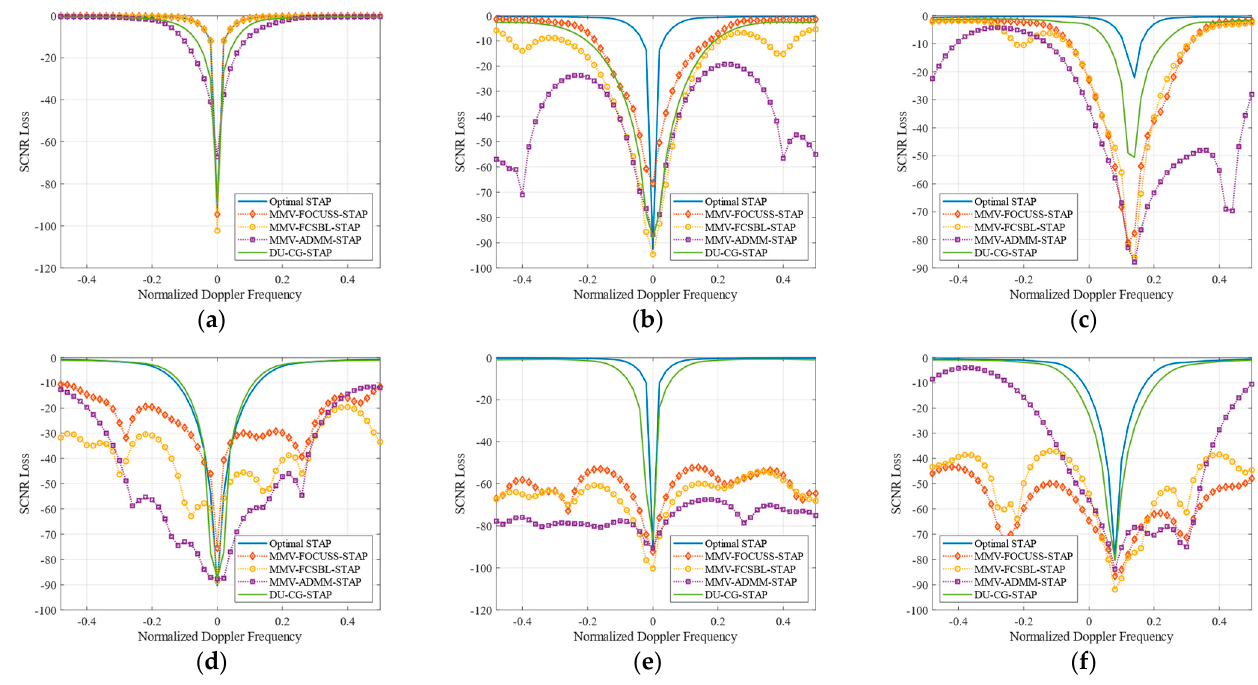
Figure 14. SCNR loss curves of different methods for a target with zero spatial frequency and varying Doppler frequency; subfigures ( a – f ) correspond to Figures 8–13, respectively.